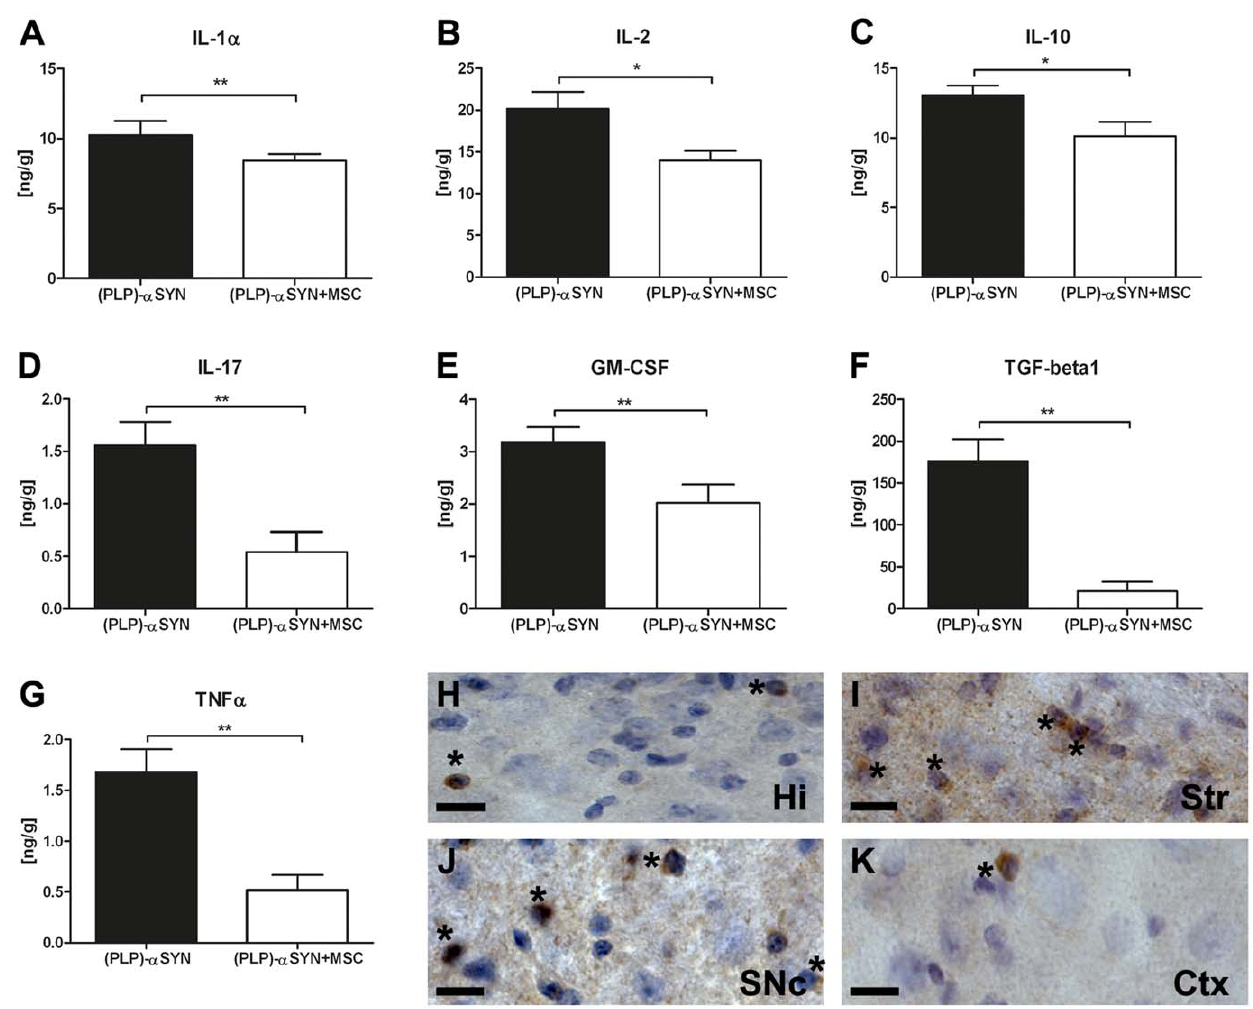
Figure 5. Influence of MSC treatment on cytokine concentrations in midbrain-brainstem lysates. Cytokine levels in midbrain-brainstem lysates were quantified by flow cytometry. Significant downregulation of IL-1 a (p=0.0014) ( A ), IL-2 (p=0.019) ( B ), IL-10 (p=0.046) ( C ), IL-17 (p=0.056) ( D ), GM-CSF (p=0.029) ( E ), TGF- b 1 (p=0.001) ( F ) and TNF a (p=0.001) ( G ) in MSC treated animals (n=7) versus controls (n=6) was observed. All data are presented as means 6 SEM and were analysed by the Student’s unpaired t-test . (* p , 0.05; ** p , 0.01; *** p , 0.001). Representative CD3 + stainings counterstained with Mayer’s haematoxylin solution demonstrated invading T-cells throughout the brain, as presented here in hippocampus ( H ), striatum ( I ), substantia nigra pars compacta ( J) and cortex ( K ) in (PLP)- a SYN transgenic animals. A similar staining pattern was observed in (PLP)- a SYN + MSC treated animals. Scale bar ( H , I , J , K ) represents 10 m m. Asterisk indicate CD3 + T-cells. Hi, hippocampus; Str, striatum, SNc, substantia nigra pars compacta; Ctx,